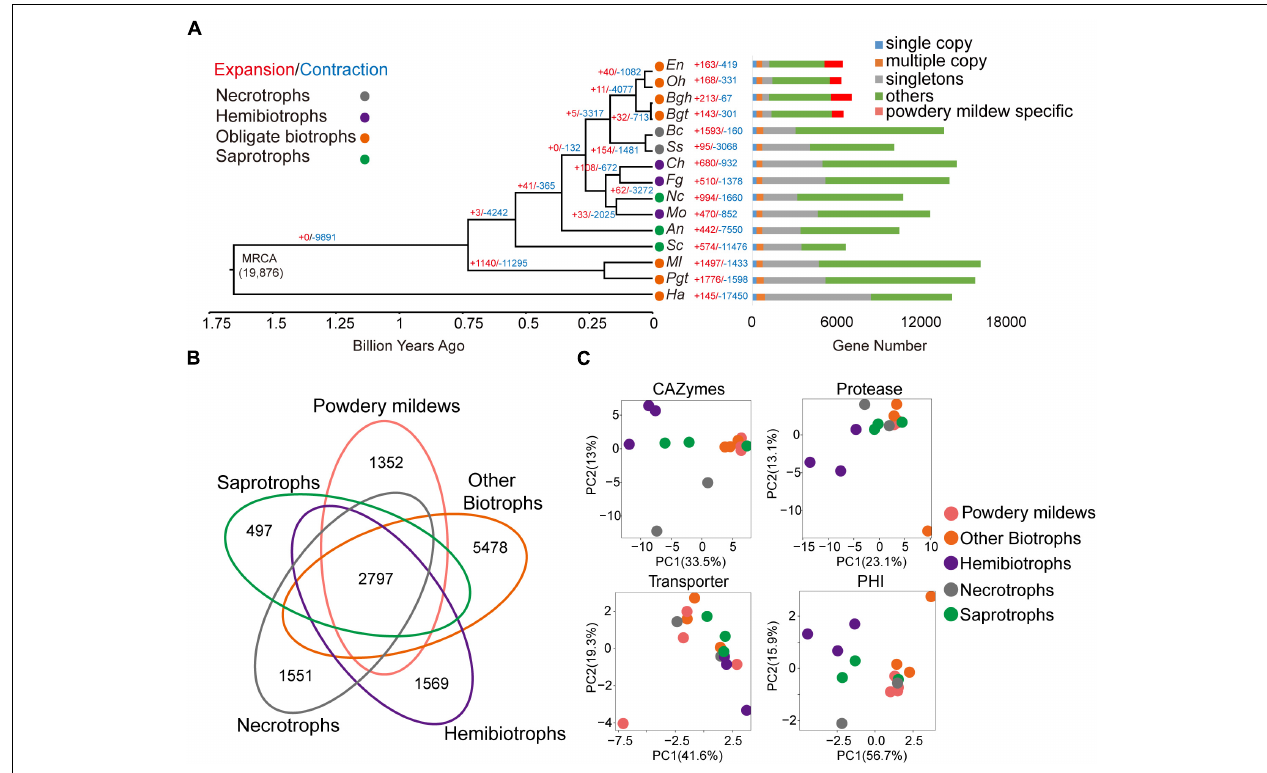
FIGURE 1 | Powdery mildews have contracted gene family sizes and a similar pathogenicity-related repertoire for their obligate biotrophic lifestyle. (A) The phylogenetic relationship, expansion, and contraction of gene families among 15 microorganisms. The phylogenetic tree is based on single-copy, orthologous gene families shared by all species. Branch numbers indicate the number of gene families that have expanded (red) and contracted (blue) after the split from the common ancestor. MRCA, most recent common ancestor. Circle colors represent different lifestyles. Time lines indicate divergence times among the species. The bar diagram shows the distribution of genes based on the orthologous gene clusters. The following abbreviations in all figures are used for each species: Oidium heveae ( Oh ), Erysiphe necator ( En ), Blumeria graminis f. sp. hordei ( Bgh ), Blumeria graminis f. sp. tritici ( Bgt ), Puccinia graminis f. sp. tritici ( Pgt ), Melampsora laricis-populina ( Ml ), Hyaloperonospora arabidopsidis ( Ha ), Magnaporthe oryzae ( Mo ), Colletotrichum higginsianum ( Ch ), Fusarium graminearum ( Fg ), Sclerotinia sclerotiorum ( Ss ), Botrytis cinerea ( Bc ), Saccharomyces cerevisiae ( Sc ), Aspergillus nidulans ( An ), Neurospora crassa ( Nc ). (B) The Venn diagram shows shared and unique orthologous families among different trophic lifestyles. Gene families from every lifestyle are the sum of the families from species belonging to the same lifestyle. (C) Principal component analysis based on CAZymes, protease, transporter, and pathogen-host interaction (PHI) genes for different